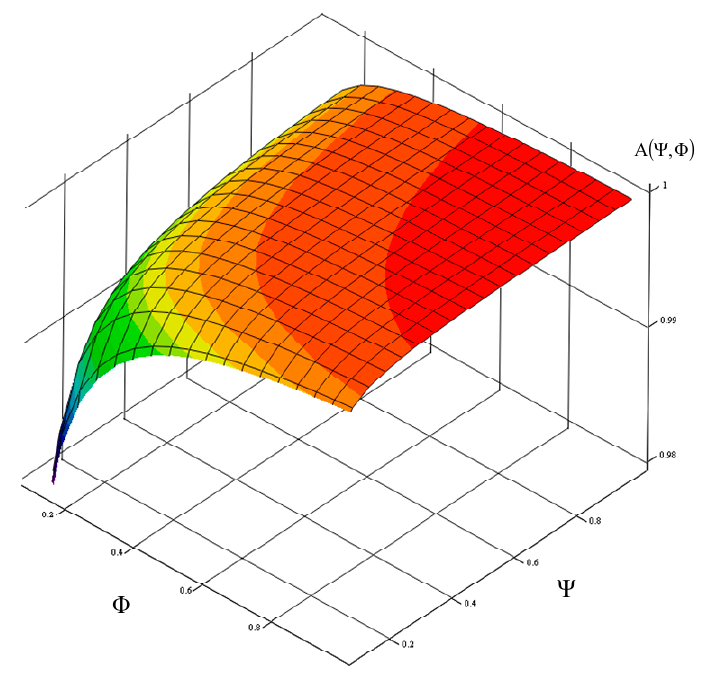
Figure 3. Graph showing the impact of a toll collection station replaceable module demand index and the index on expenditure on replaceable modules, on the value of its readiness index. Source: own